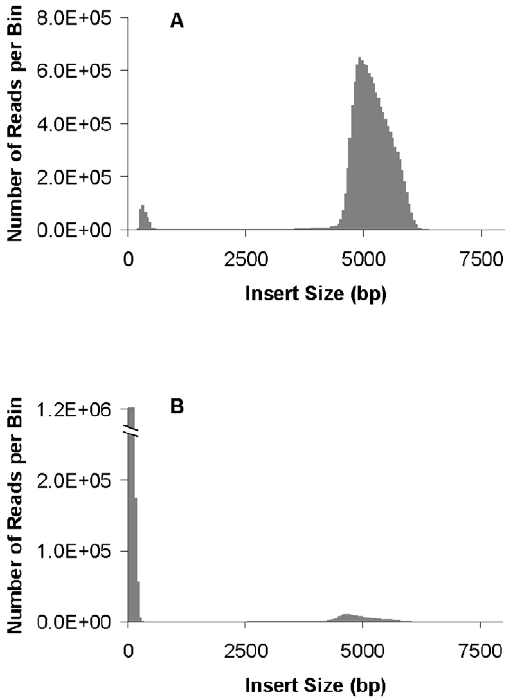
Figure 2. Histogram of insert lengths from the Haloterrigena turkmenicaVKM,DSM5511 5 kb mate pair libraries. A: CLIP-PE method, B: Illumina jumping method. The distribution of insert lengths was determined by aligning the reads to the reference genome.